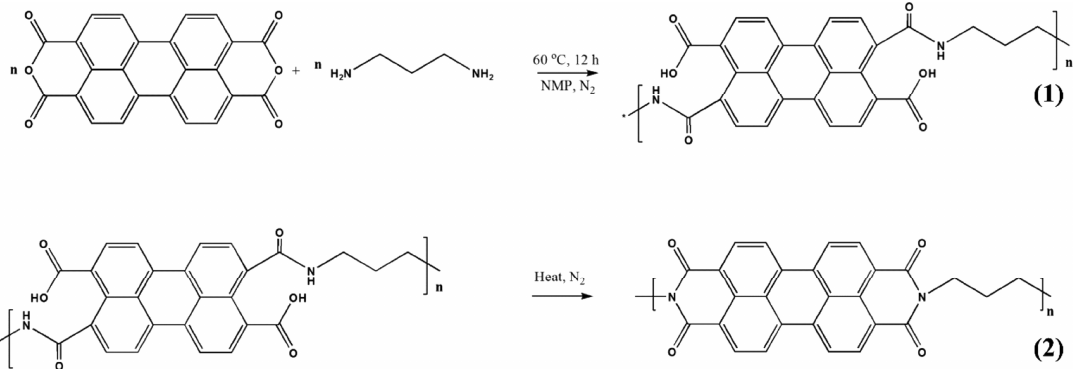
Figure 10. Representation of the synthesis of the PI / MWCNT nanocomposite. Reproduced with permission from [71].